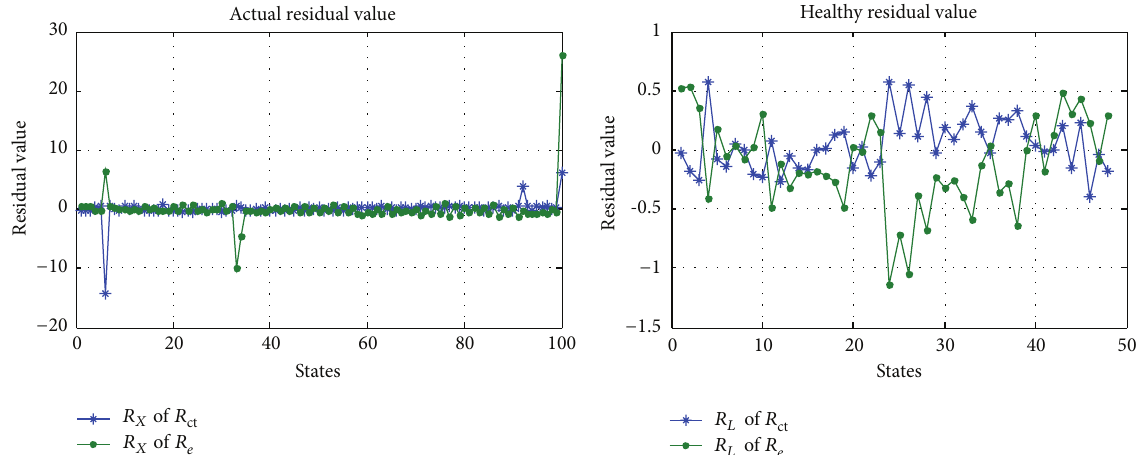
Figure 14: Actual residual value and healthy residual value of 𝑅 𝑒 and 𝑅